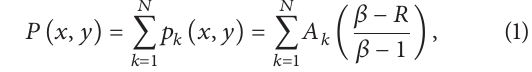
sine peaks modulated by a Hann window. A signal with an odd number of peaks is used so that there is a clear maximum peak that can be used for signal processing (if an even number of peaks were used then there would be two peaks with the same maximum